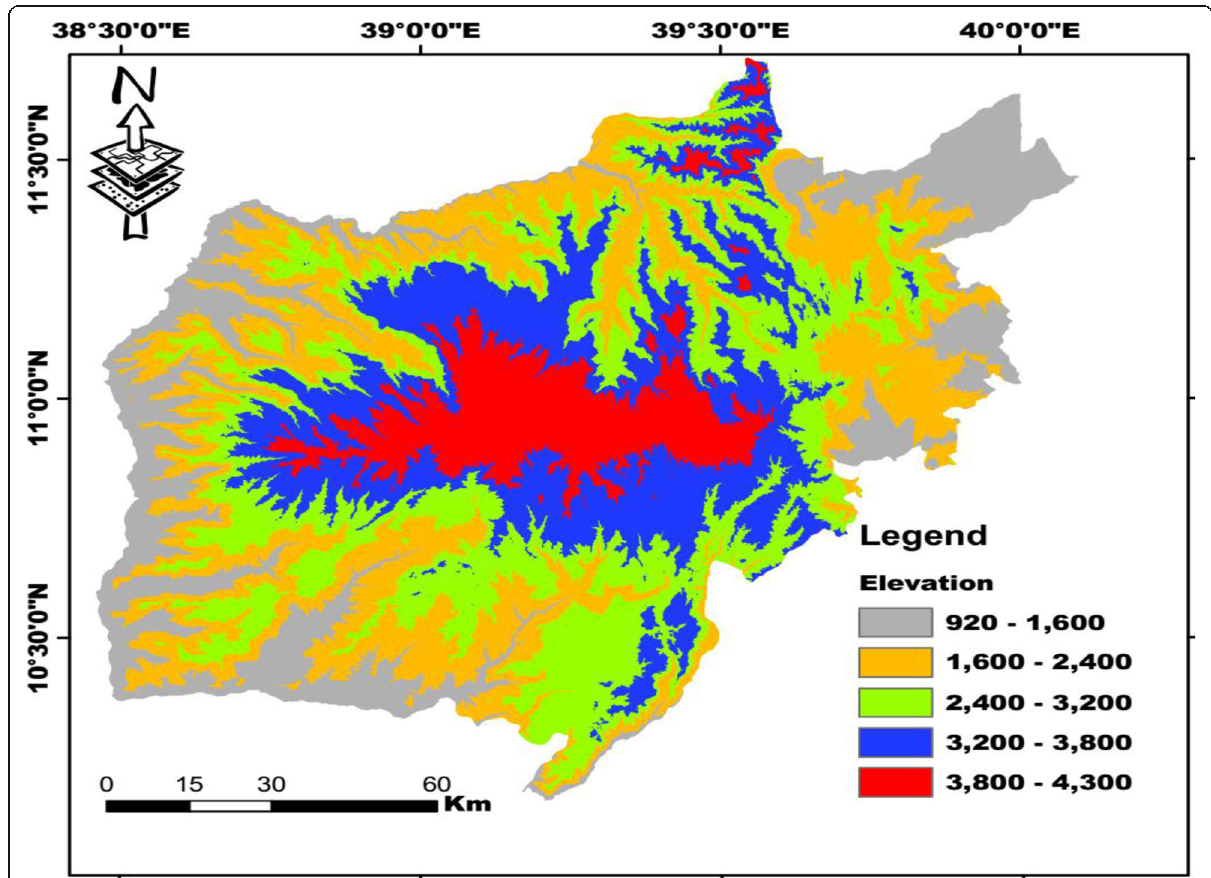
Fig. 3 The elevation classifications of South Wollo administrative